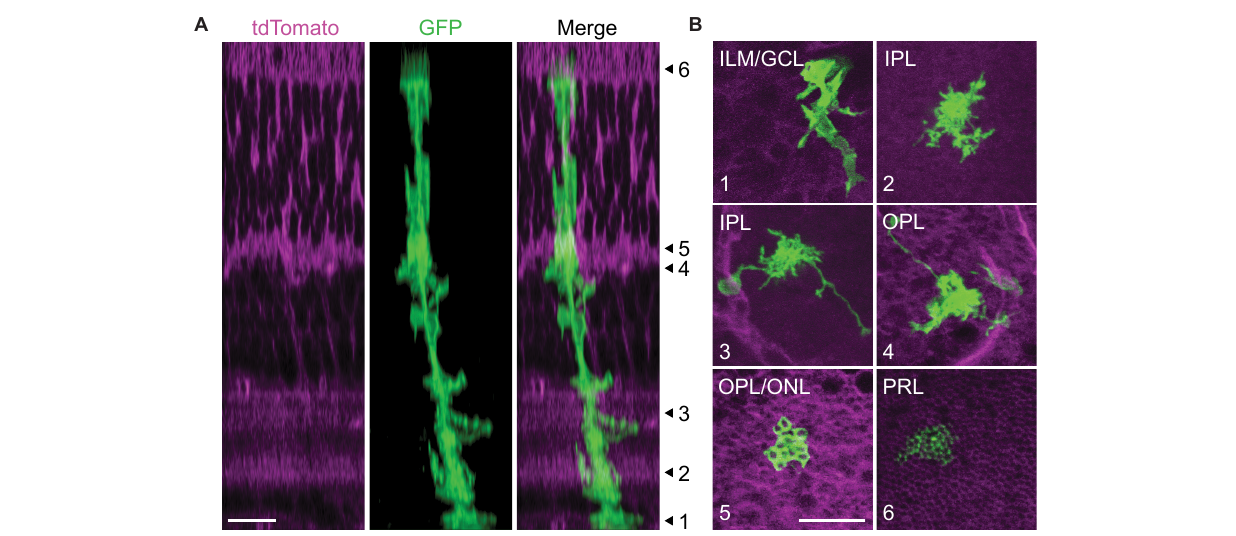
FIGURE 4 | Morphological compartments of mature Müller glia. (A) Orthogonal projection of a 2-photon volumetric image from mature GLAST/mTmG mouse retina. This mouse line expresses membrane-bound tdTomato ubiquitously, and sparse activation of Cre recombinase induces expression of membrane-bound GFP in a subset of Müller glia. Numbered arrowheads correspond to focal planes shown in (B) to highlight different morphological compartments. (B) (1) Müller glial endfeet in the inner limiting membrane (ILM) and ganglion cell layer (GCL). (2) Lateral processes in the inner plexiform laer (IPL). (3) Lateral processes and long-ranging blood vessel-contacting processes in the IPL. (4) Lateral processes and blood vessel-contacting processes in the outer plexiform layer (OPL). (5) Photoreceptor terminal-ensheathing processes at the OPL-outer nuclear layer border. (6) Müller glial microvilli extending between photoreceptor inner segments. PRL: photoreceptor layer. Scale bars 10 µ m. From Tworig, unpublished